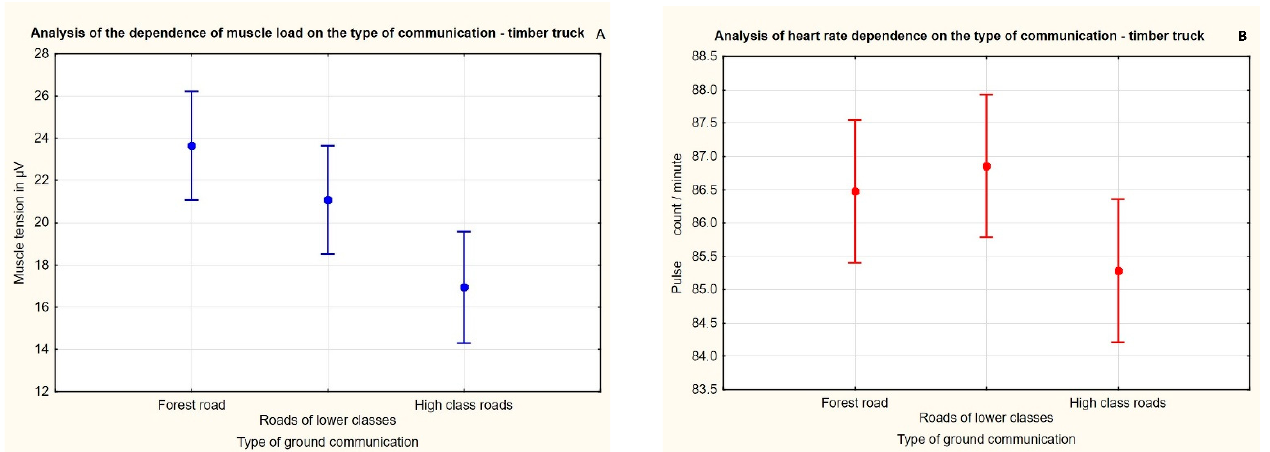
Figure 5. Dispersion analysis of the dependence of muscle load values ( A ) and heart rate ( B ) on the type of communication used when driving the timber truck (author). Table 7. Post hoc test to analyze the variance of muscle load values depending on the type of communication when driving the timber truck. The red text indicates statistical significance.